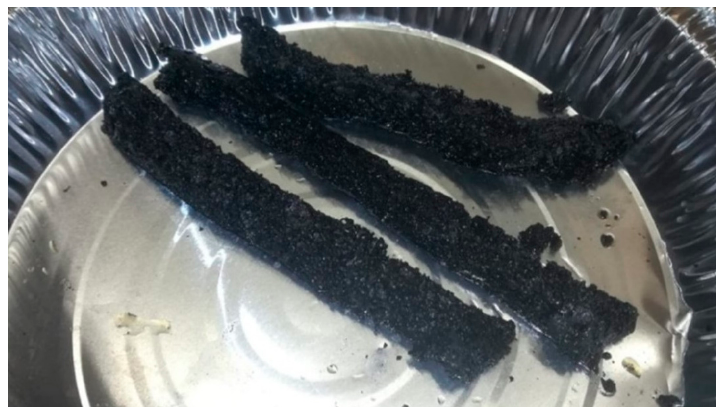
Figure 1. Photograph of carbon foam from the furnace.